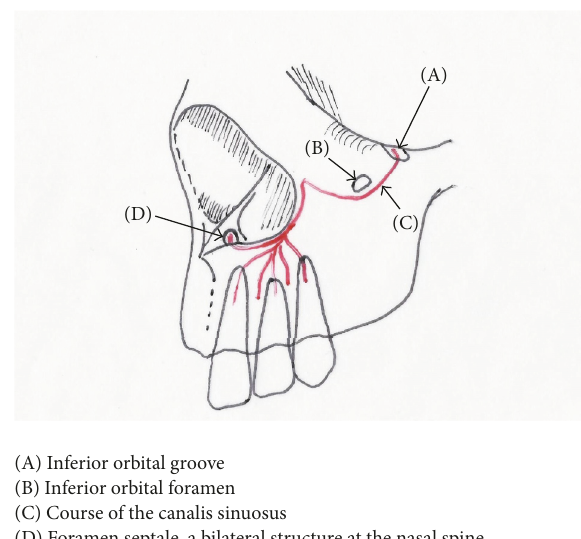
Figure 1: Schematic of maxilla describing the course of the canalis sinuosus .